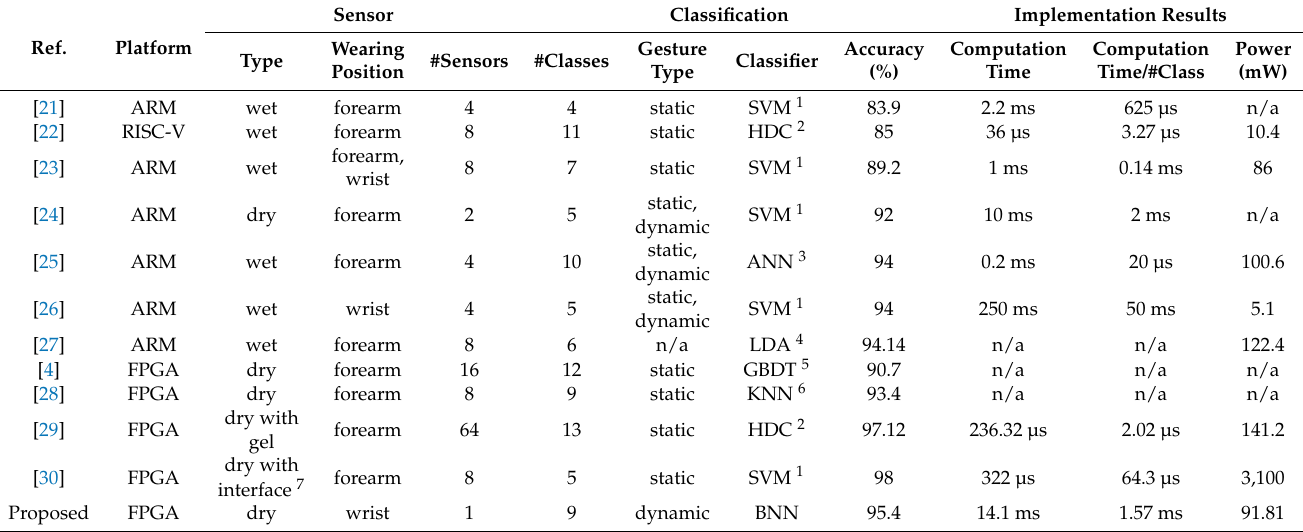
Table 7. Comparison results between the proposed HGR system and the previous sEMG-based HGR systems implemented on MCU and